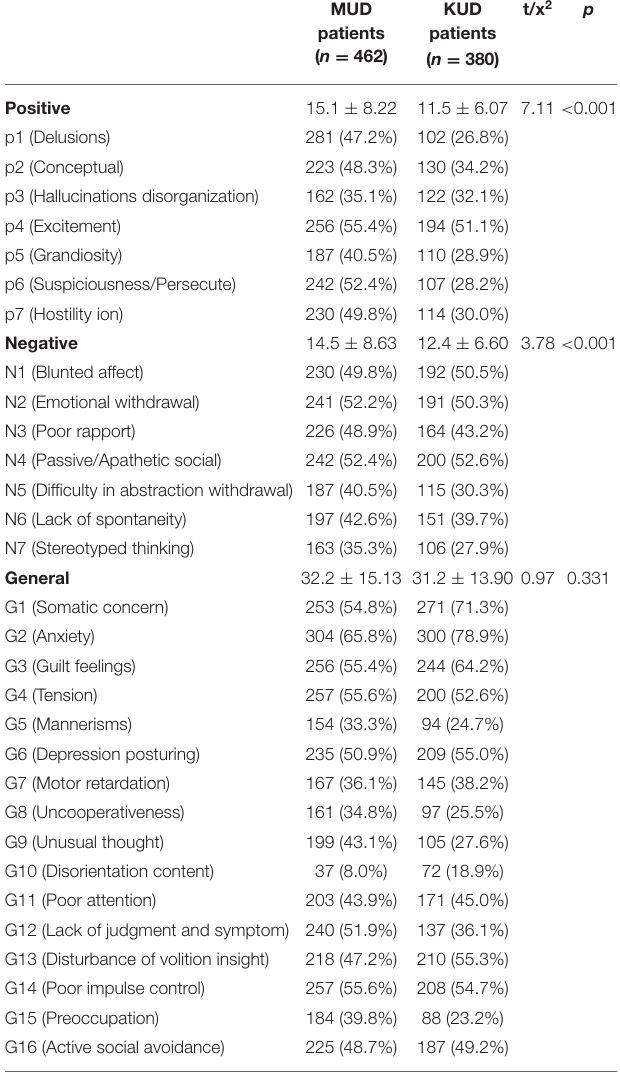
TABLE 2 | MLR model predicting increase in PANSS total score. Variable